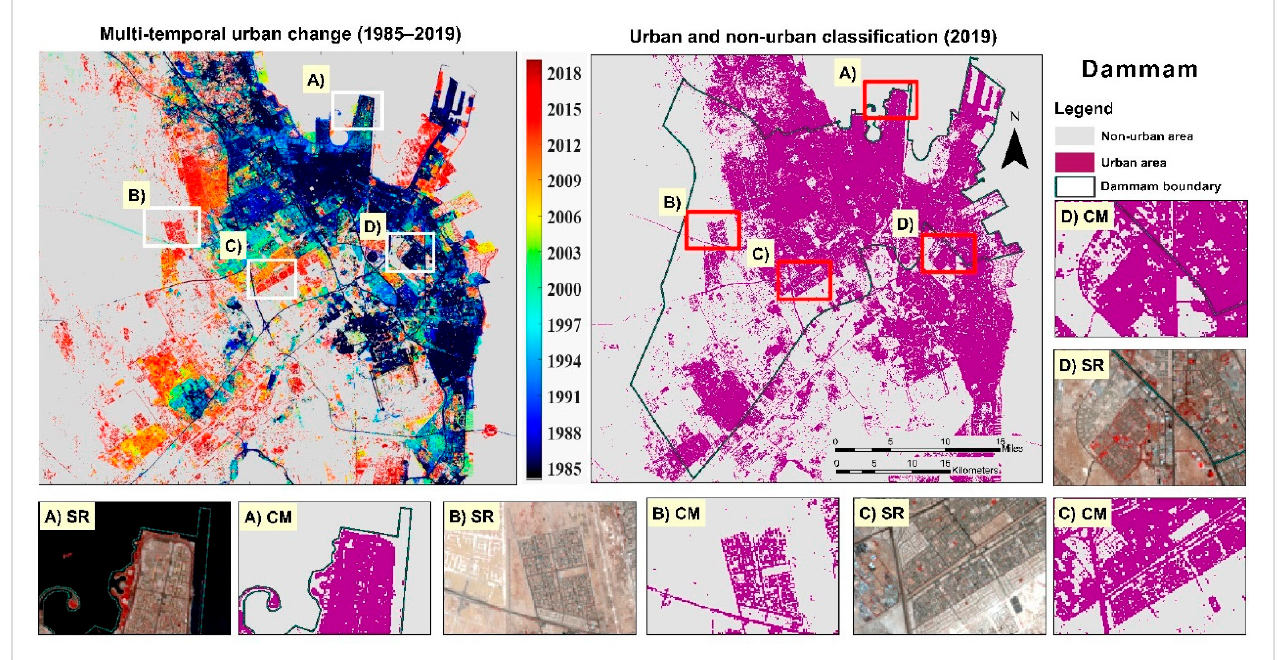
Figure 11. Multi-temporal urban change map (1985–2019) and urban and non-urban classifications in 2019 in Dammam. Both include surface reflectance (SR) and classification map (CM) samples.